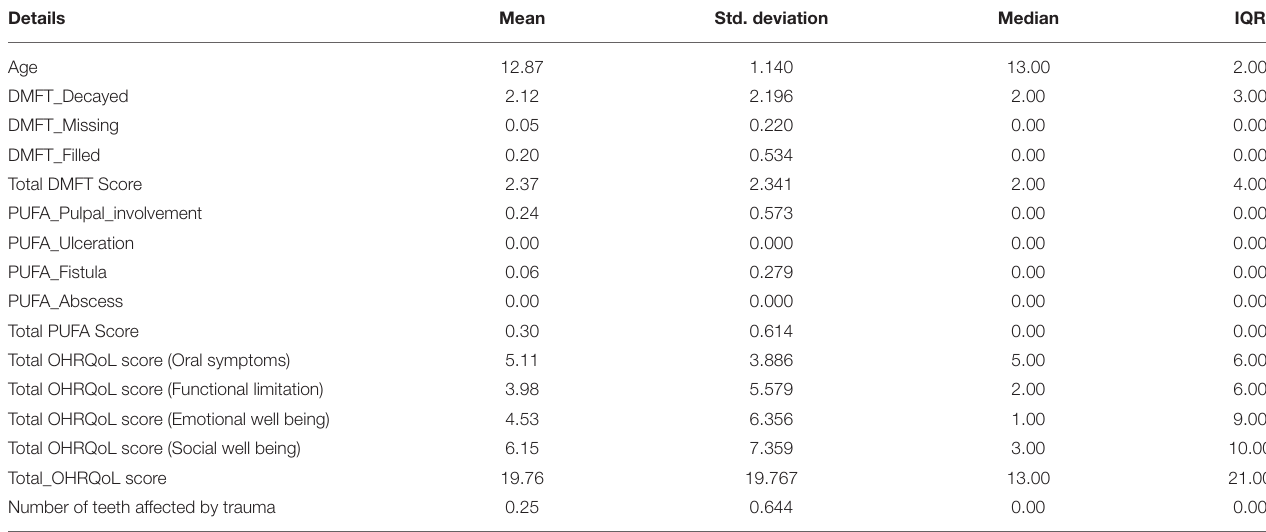
TABLE 2 | Overall DMFT, PUFA, and OHRQoL scores, and trauma. Details